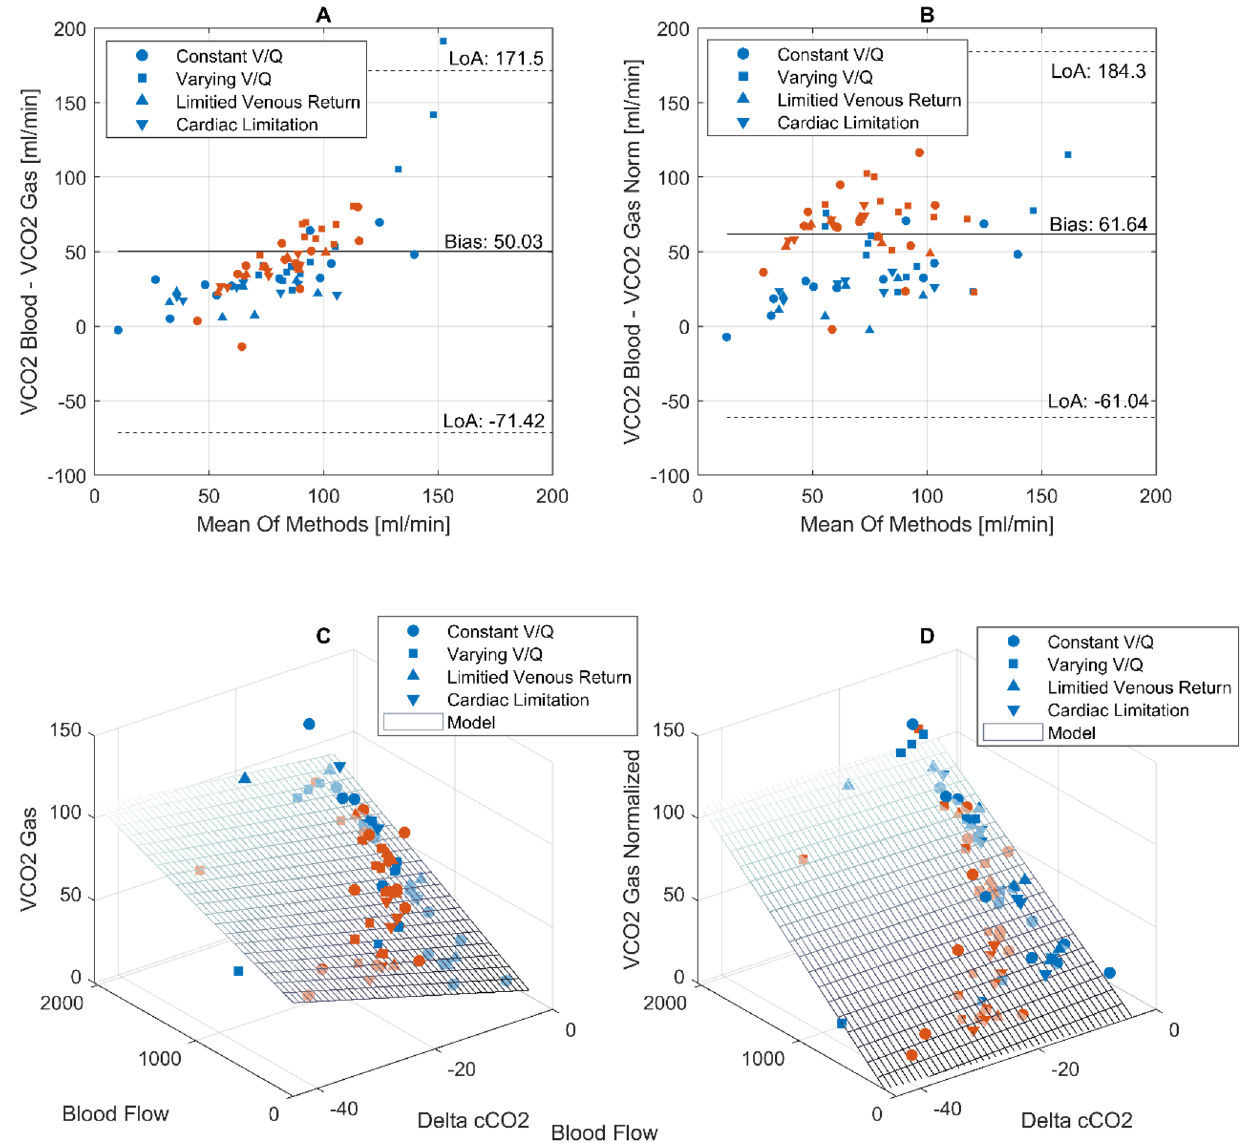
. . V CO V CO Figure 6. ( A ) Bland–Altman plot for 2Blood against 2Gas . ( B ) Bland–Altman plot for V CO . . 2GasNorm . Multiple regression analysis showing the relationship between Blood Flow, Delta in CO 2 Content V CO V CO and 2Gas ( C ) and 2GasNorm ( D ). Regression coefficients can be found in Table 1. Values from Oxy ECMO are blue while values from Oxy Lung are in orange color.